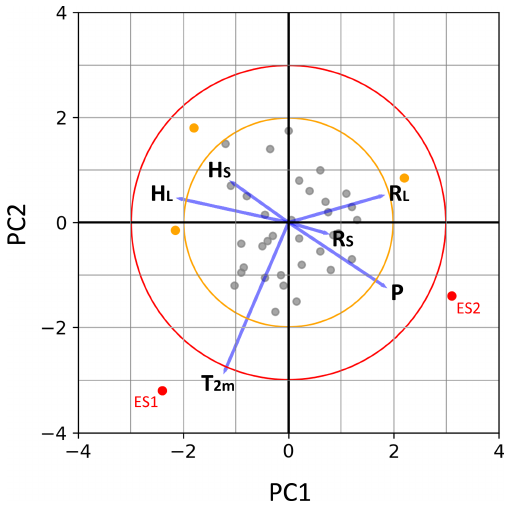
Figure 2. Schematic PCA biplot with PC1 along the x axis and PC2 along the y axis. Grey dots represent single seasons, and red (orange) dots show extreme (anomalous) seasons. Blue lines rep- resent the projections of the original parameters onto the first two principal components. Values of d M = 2 and d M = 3 are shown by orange and red circles,